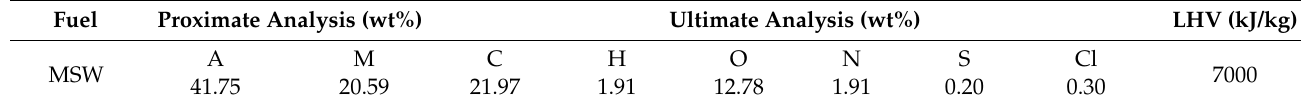
Figure 1. Diagram of the reference WTEU. Table 1. Properties of the fuel used by WTEU (as received basis).